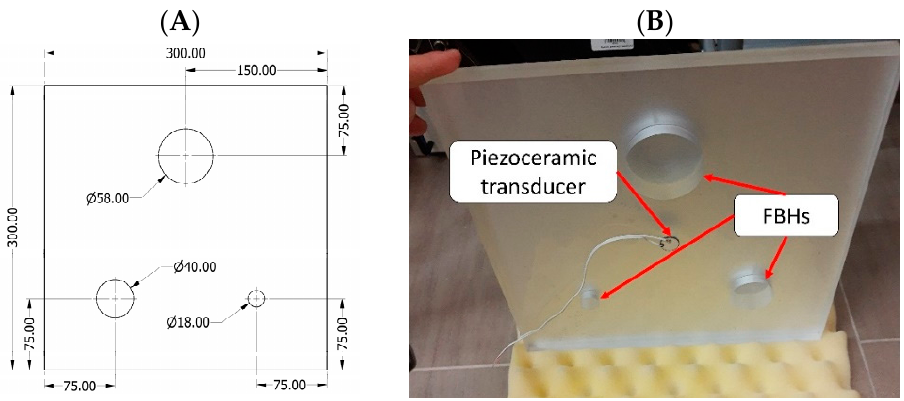
Figure 3. PMMA test sample with FBHs: nominal dimensions in [mm] ( A ) and the sample prepared for experiments ( B ).